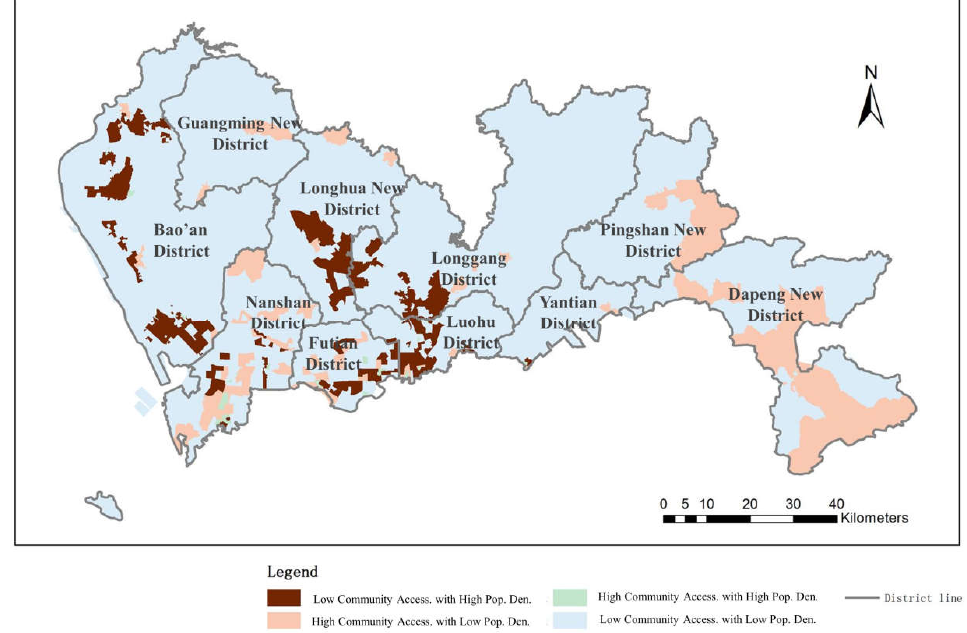
Figure 12. Balance evaluation between community-level hospital accessibility and population density.